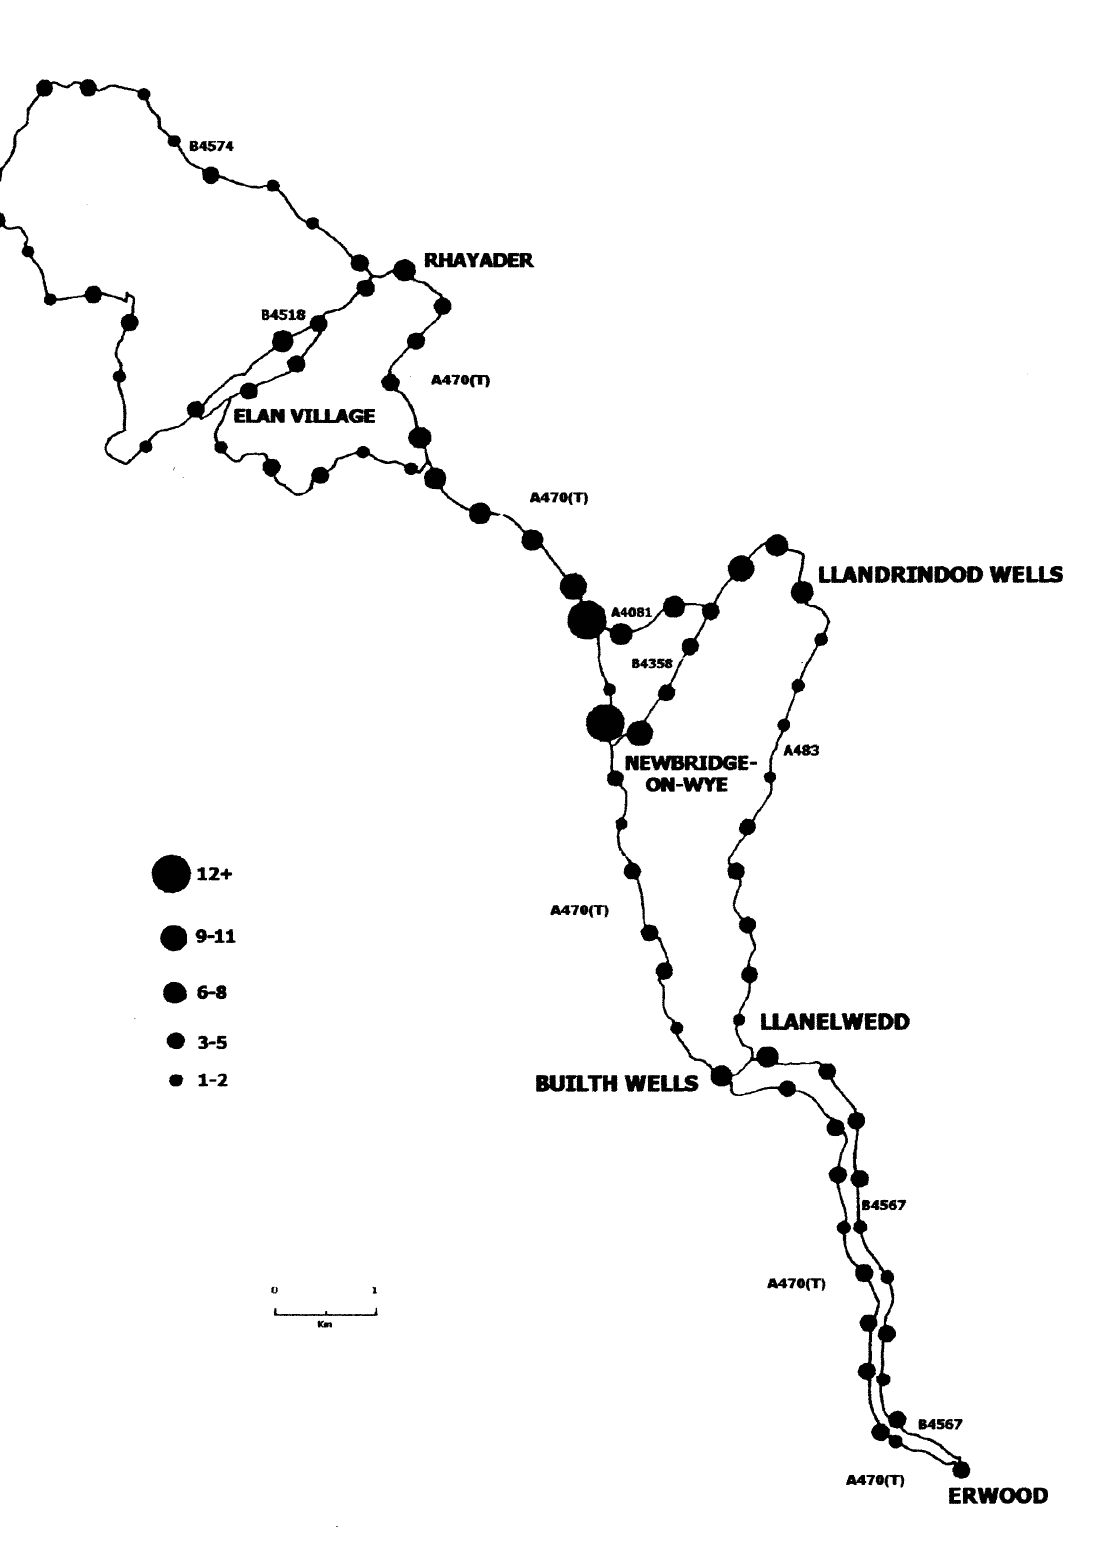
Fig. 1. Map showing the road circuit surveyed and total casualties recorded per section. The A470 follows the course of the River Wye, the altitude at Erwood is 120 m and at the extreme northern point of the circuit is 488 m on the hills above